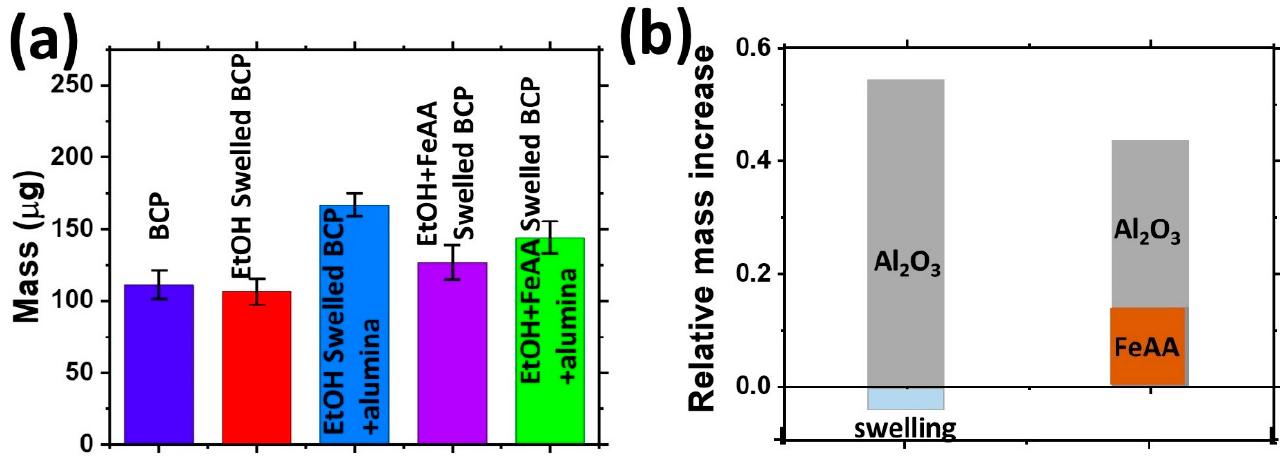
Figure 2. Quartz crystal microbalance (QCM) monitoring of the swelling and infiltration processes of PS-P4VP template from the Fe(acac) 2 solution and from vapor-phase: ( a ) the mass increase during different stages of polymer modifications, and ( b ) relative mass increase upon material infiltration as compared to the initial mass of the polymer film during the vapor-phase infiltration (left bar) and during solution and vapor-phase infiltration (right